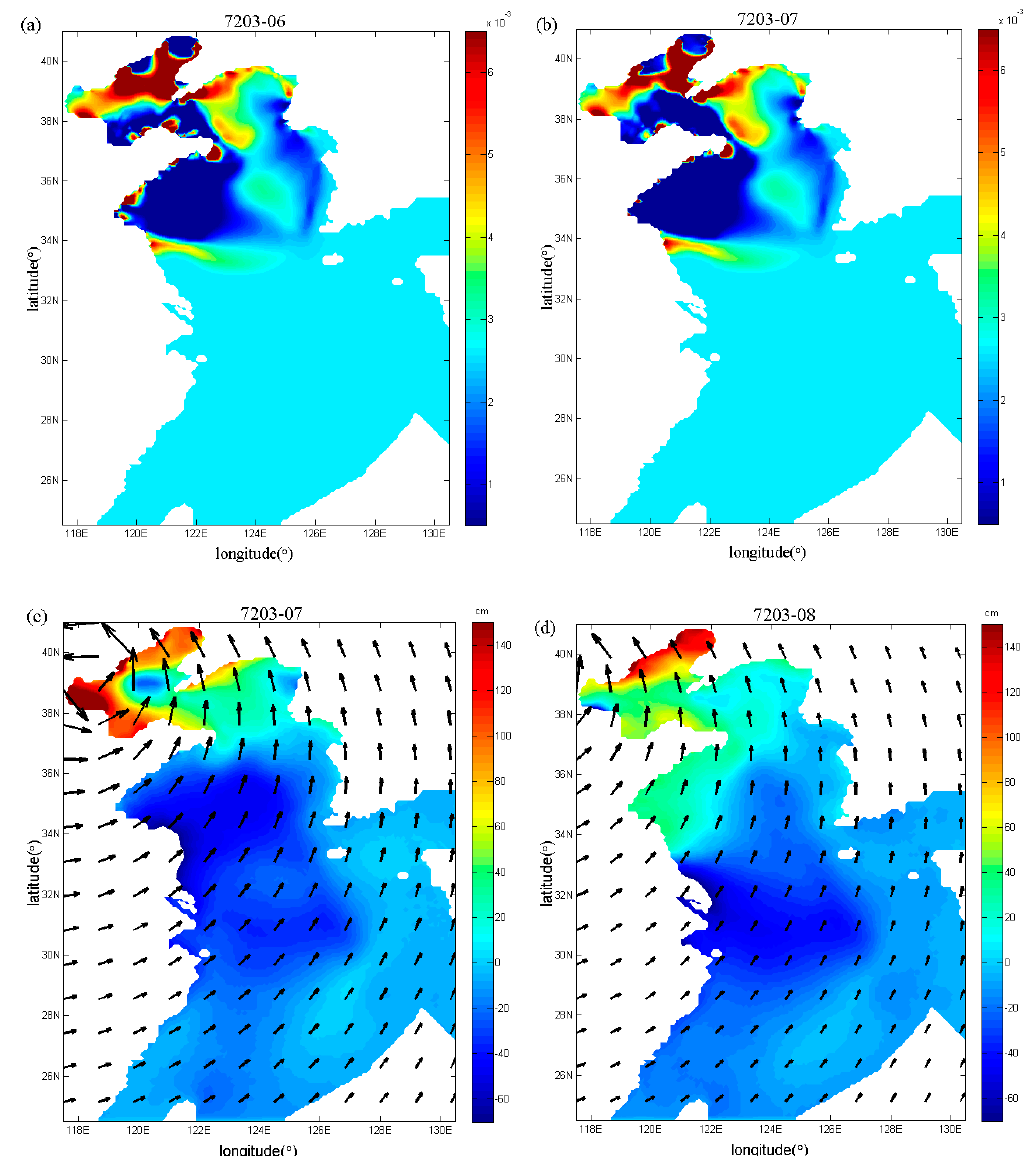
Figure 9. Spatial distributions ( a , b ) of the drag coefficient in the sixth and seventh periods and spatial distributions ( c , d ) of storm surge elevation and wind field in the seventh and eighth periods in Case 3 during Typhoon 7203.